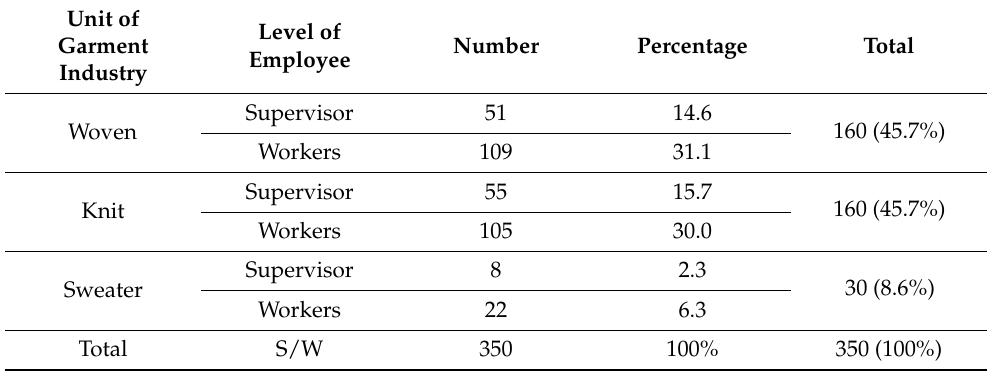
Table 1. Distribution of samples based on organization type and employee level (N =